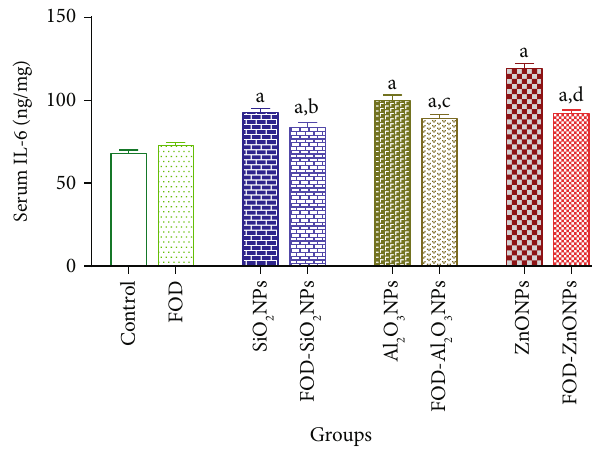
Figure 4: The e ff ects of fi g with olive oil and date-palm fruit extracts (FOD) on the serum interleukin-6 (IL-6) in rats treated with di ff erent nanoparticles (NPs) for 75 days. a p < 0 : 05 versus control group; b p < 0 : 05 versus SiO O NPs; d p < 0 : 05 versus ZnONPs. N.B: the antioxidants Al 2 3 (FOD) treatments were used for 2 weeks before and during the administration of the